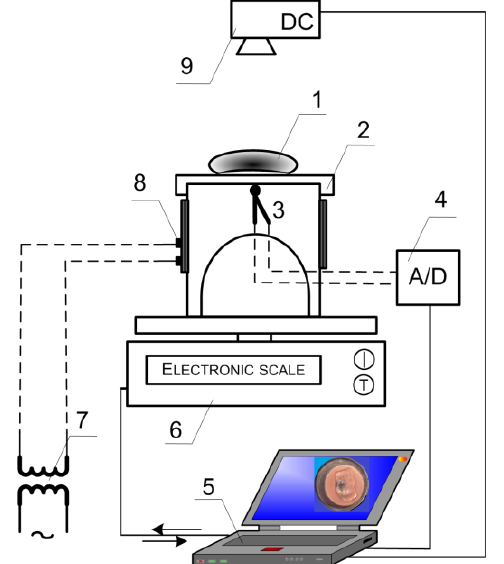
Fig. 1. Experimental set-up: 1 - droplet, 2 - cylinder, 3 - thermocouple, 4 - A/D station, 5 - data acquisition station, 6 - scale, 7 - autotransformer, , 8 - heater, 9 - digital camera.